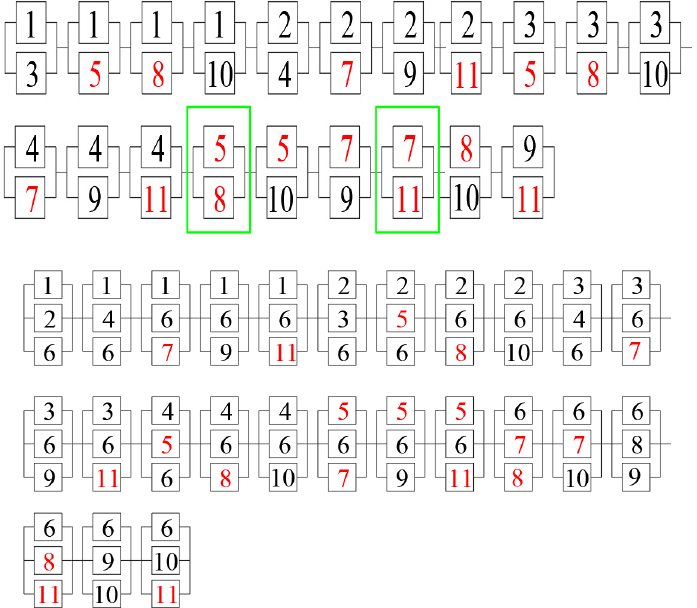
Figure 3. Full cut-sets for the truss with two degrees of freedom (Figure 1).